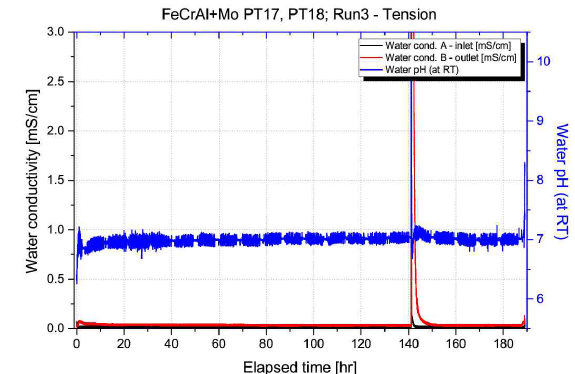
Figure 16. FeCrAl+Mo Run 3 - Water inlet and outlet conductivity and